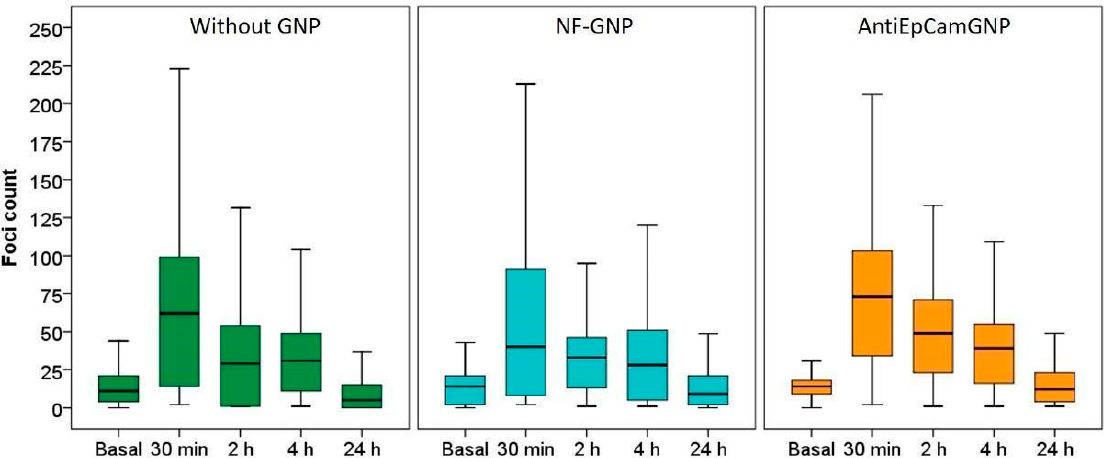
Figure 8. Box plots of the number of foci per cell in Caco2 cells before (basal) and at different times (30 min, 2, 4 and 24 h) after irradiation, in the absence of GNPs (Without GNP) or in the presence of non-functionalized GNPs (NF-GNP) or anti-EpCam-functionalized GNPs (AntiEpCamGNP). Horizontal lines inside boxes indicate the median.